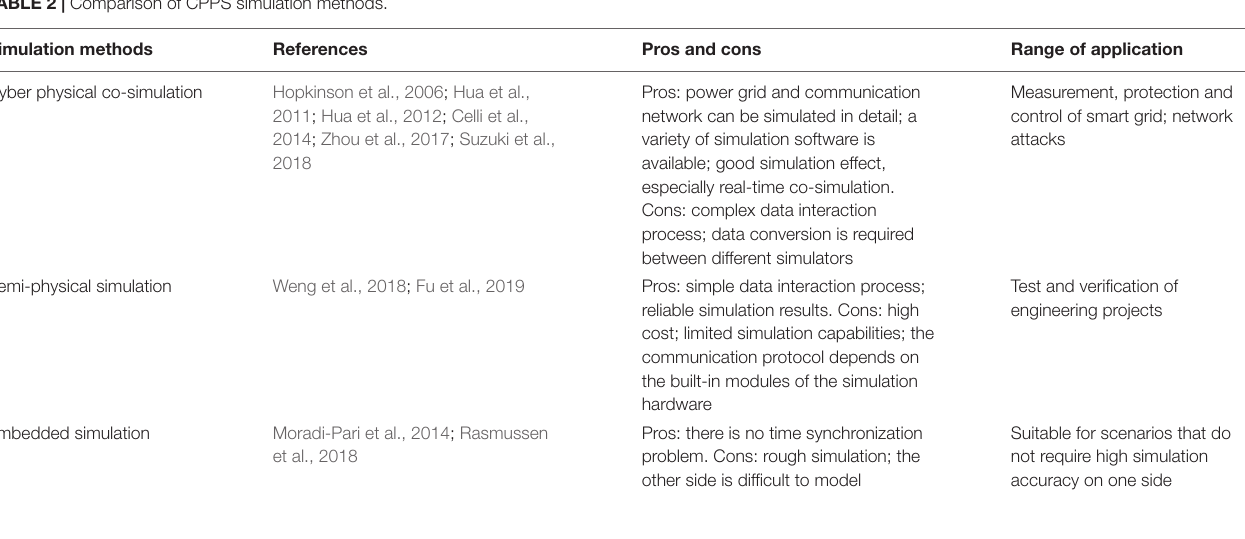
FIGURE 4 | Microgrid semi-physical simulation scheme. TABLE 2 | Comparison of CPPS simulation